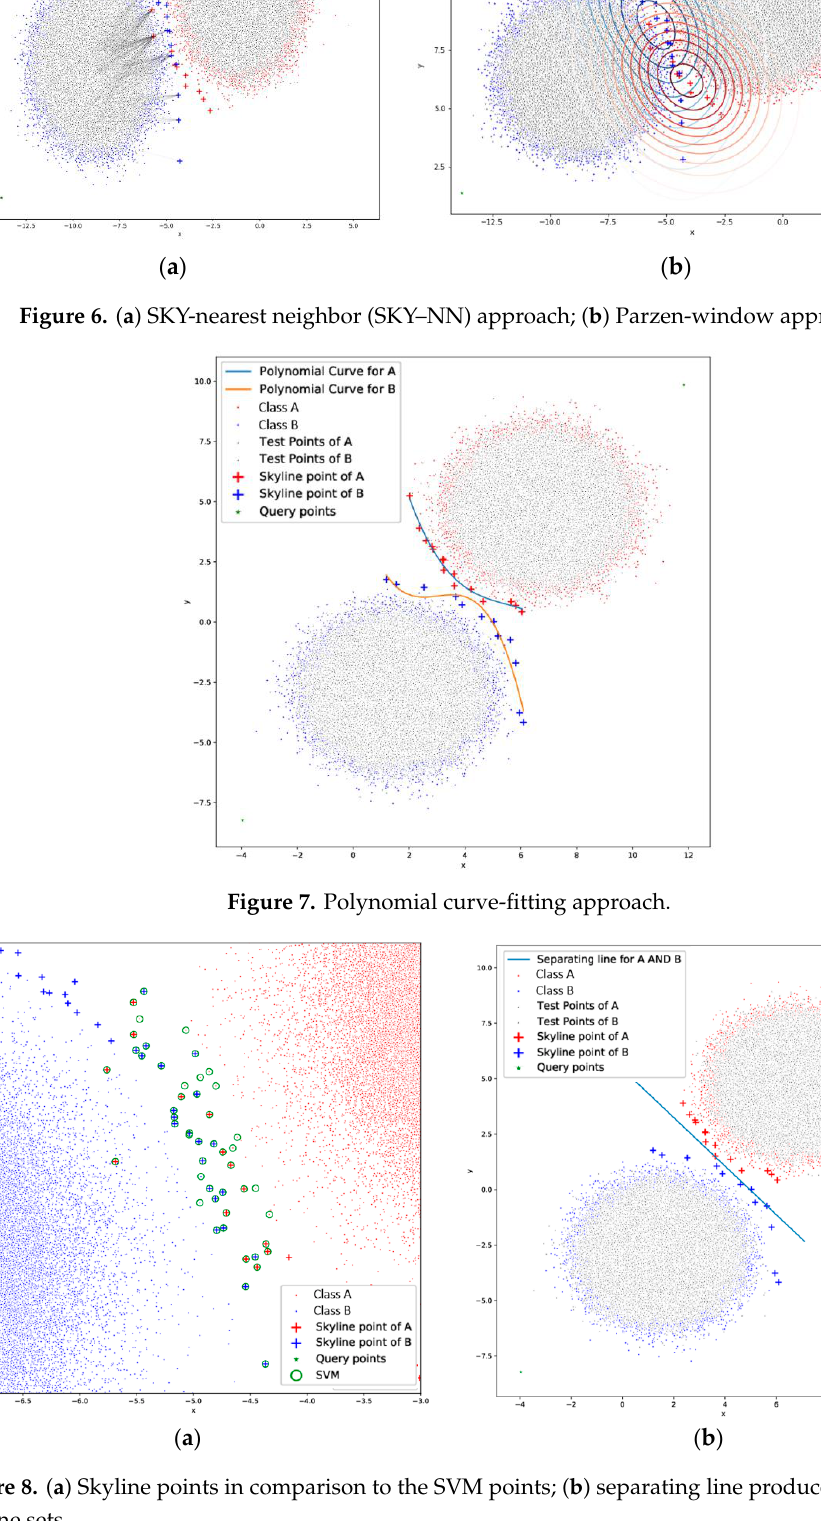
skyline sets. skyline